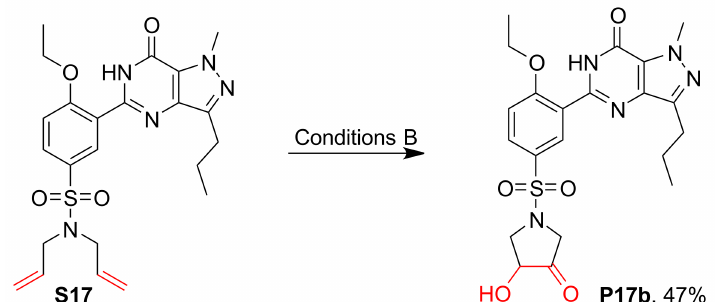
Scheme 6. One-pot CM and oxidation of an active pharmaceutical ingredient (API) derivative S17